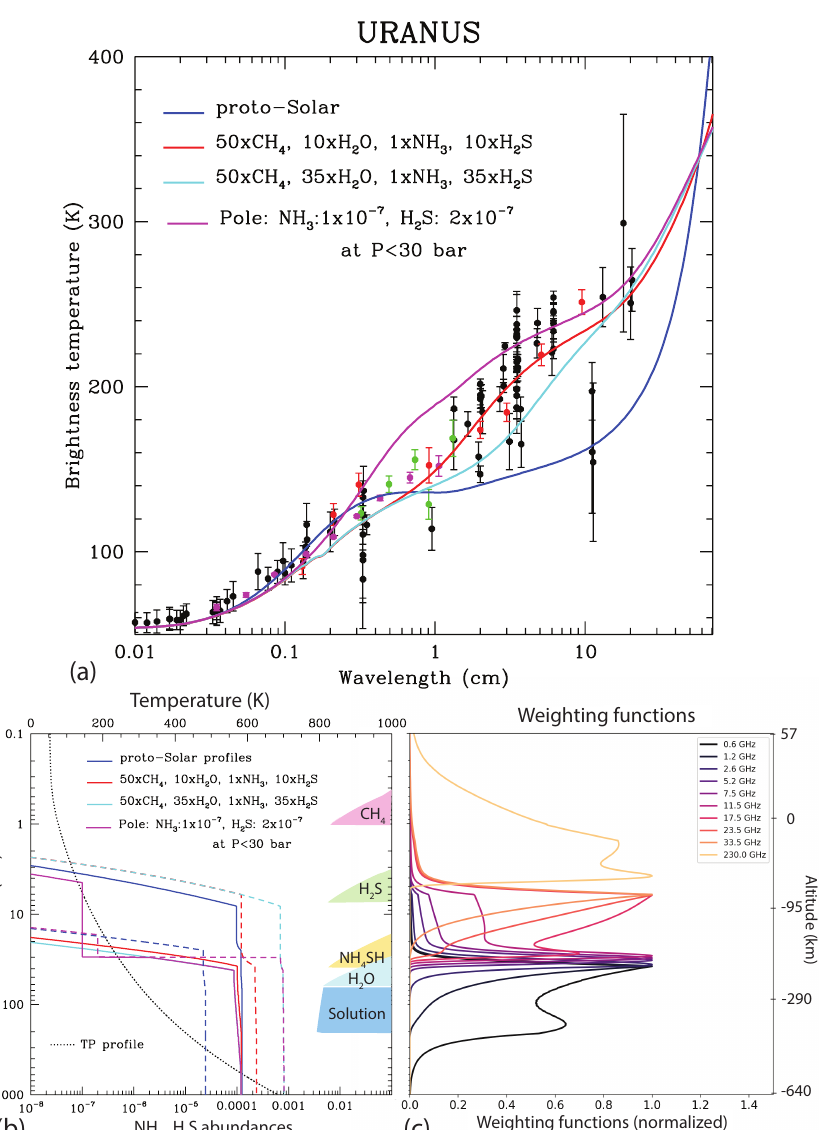
Figure 15. ( a ) Uranus’s disk-averaged brightness temperature as a function of wavelength. Red points: recent ALMA and VLA data [57]. Black points: older data points measured or compiled by Refs. [132,134,135,139]; Green points: WMAP data [84]; Magenta points: Planck collaboration [87,88]. The curves are model calculations: Blue: solar abundances for all gases; Cyan: abundances of CH 4 , H 2 O, and H 2 S in the planet’s deep atmosphere are enhanced by a factor of 50, 35, and 35 over the solar C, O, and S, resp. NH 3 was kept at the solar N value, and is therefore removed above the NH 4 SH cloud layer. This model fits Uranus’s mid-latitudes best. Magenta: Same deep atmosphere as the cyan line, but NH 3 = 0.1 ppm and H 2 S = 0.2 ppm at pressures P < 30 bar. This model fits Uranus’s polar region best. Red: abundances of CH 4 , H 2 O, and H 2 S in the planet’s deep atmosphere are enhanced by a factor of 50, 10, and 10 over the solar abundances, with NH 3 equal to the solar abundance. ( b ) NH 3 (solid lines), H 2 S (dashed lines) and the temperature profile (dotted line; wet adiabat) used in panel a . ( c ) Weighting functions for the red model in panels a , b